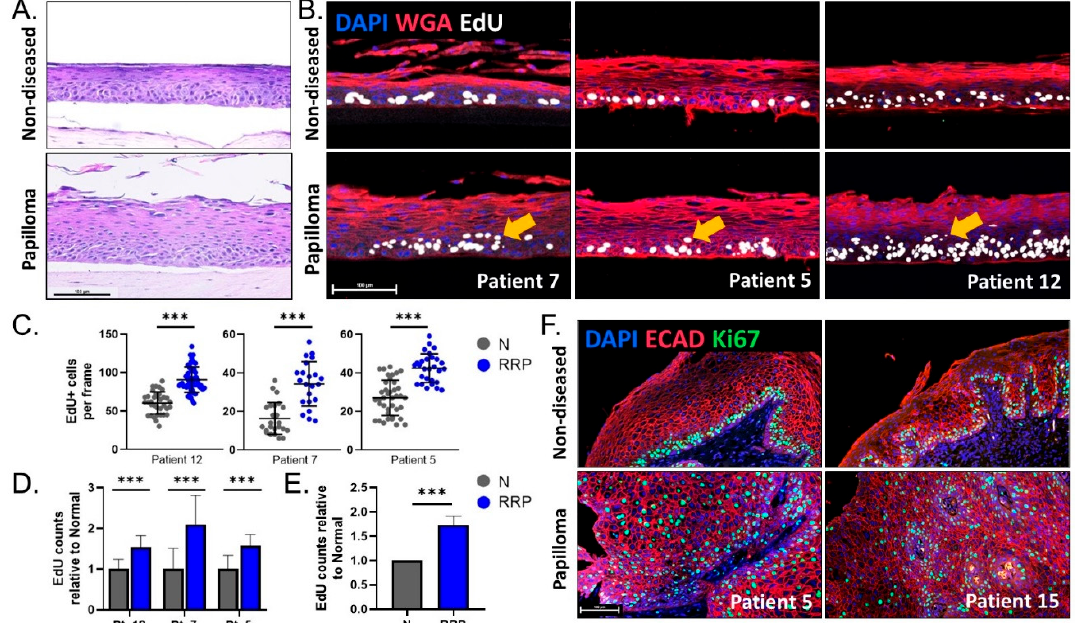
Figure 3. ( A ) Representative H&E of 3D organotypic rafts from patient 12 showing morphological changes in papilloma-derived rafts. ( B ) IF analysis for DAPI (blue), WGA (membrane marker, red), and EdU (white) on 3D rafts from three patients. Arrows indicate suprabasal EdU+ proliferating cells in papilloma-derived organotypic rafts. ( C ) Quantification of EdU+ cells per frame for organotypic rafts depicted in (B) (n = 22–40 frames). Y-axis is adjusted per patient based on the baseline level of proliferation in the non-diseased raft, highlighting intrinsic patient variability. ( D ) EdU counts in papilloma (blue) relative to non-diseased (gray) rafts per patient. ( E ) A relative increase in proliferation of 74% was observed between papilloma and matched non-diseased 3D organotypic rafts. ( F ) IF analysis for DAPI (blue), ECAD (membrane marker, red), and Ki67 (green) for two patients showing increased and abnormal distribution of proliferating cells in papilloma biopsies. Scale bar 100 µ m in all figures. *** = p < 0.001.